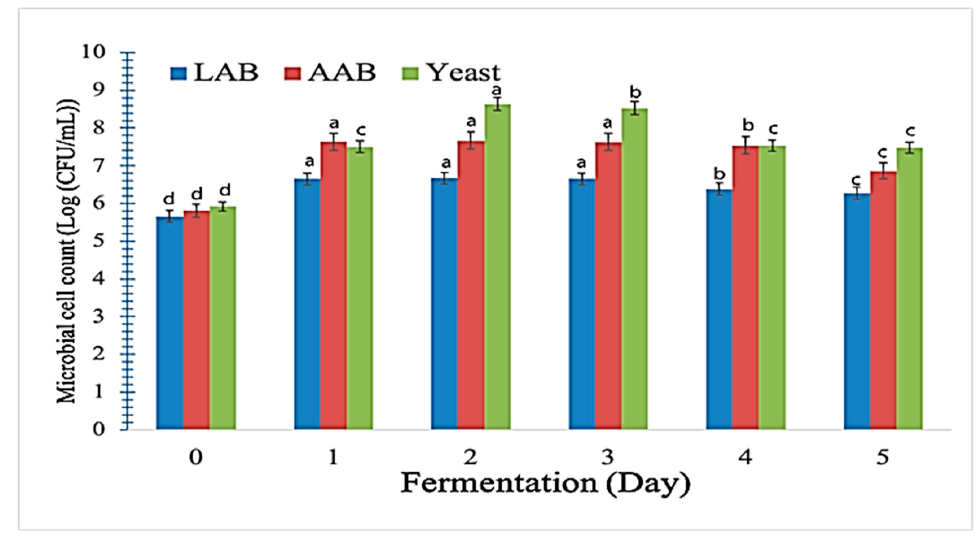
Figure 6. Developments in acetic acid bacteria (yellow bar), acetic acid bacteria (grey bar), and yeast (black bar) microbiological activity (white bar) during the water kefir-assisted fermentation of fermented and unfermented lentil–casein protein complexes at a ratio of 1.0:0.1 (LCPC 1.0:0.1). Bars with different letters differ significantly within the same color bar ( p < 0.05).